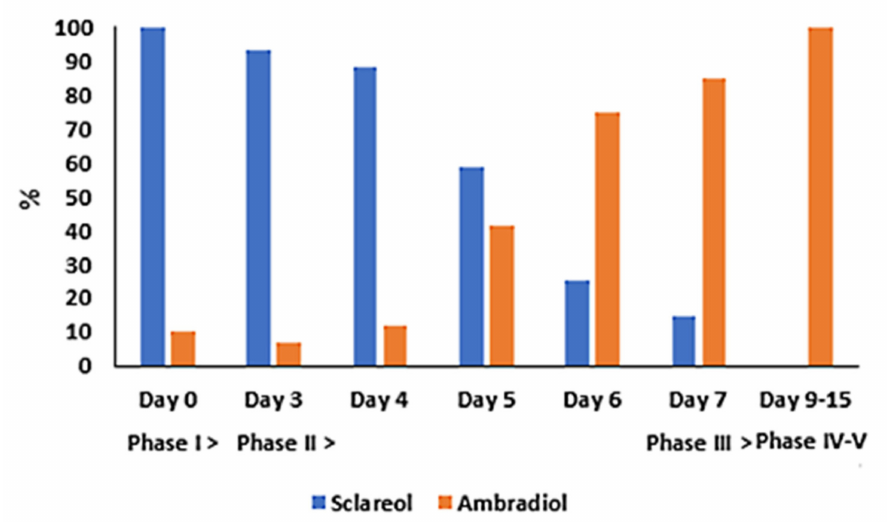
Figure 2. Semi-quantitative analysis showing the ratios (expressed as percentage) of sclareol to ambradiol present in H. roseoniger extracts across different phases of the sclareol bioconversion. Evidently, sclareol decreases in concentration from the first phase to the last, whereas the ambradiol concentration steadily increases from the first to the last